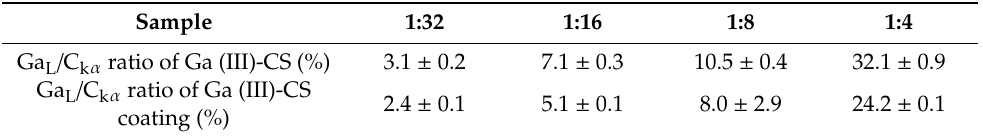
Table 2. Intensity ratios for the gallium L peak and carbon peak from EDX spectra of the as-prepared Ga (III)-CS complex and Ga (III)-CS coatings.